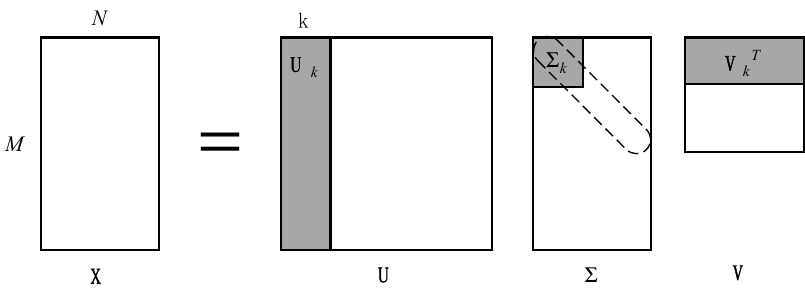
Figure 9. Schematic diagram of the singular value decomposition algorithm.